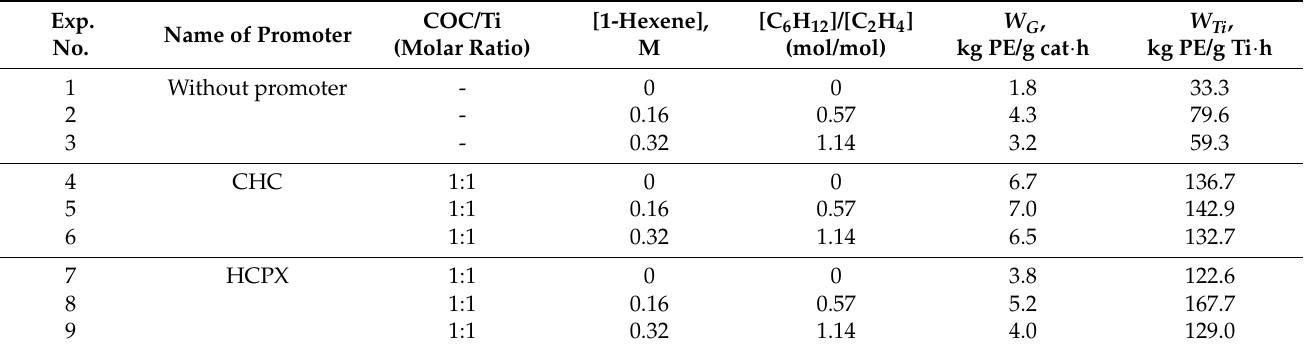
Table 2. The effect of COCs on activity of TMC during ethylene homopolymerization and ethylene/1-hexene